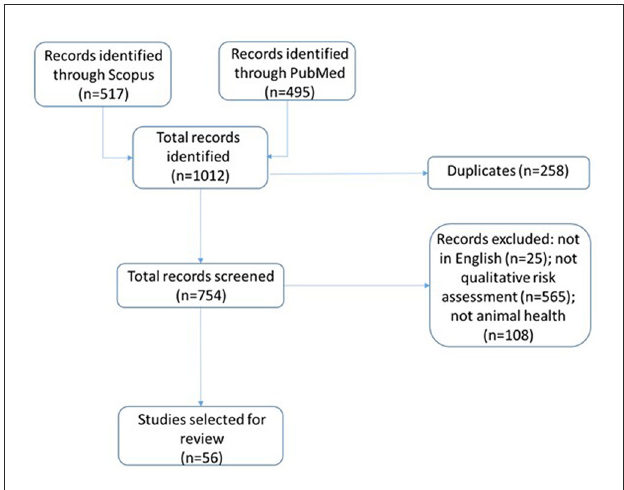
FIGURE1 Flow diagram of the decision process and exclusion criteria.